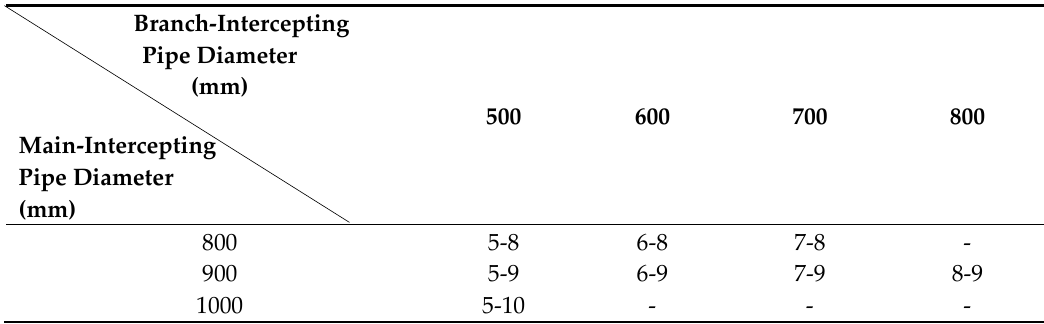
Table 3. Strategy for retrofitting intercepting sewer pipes.